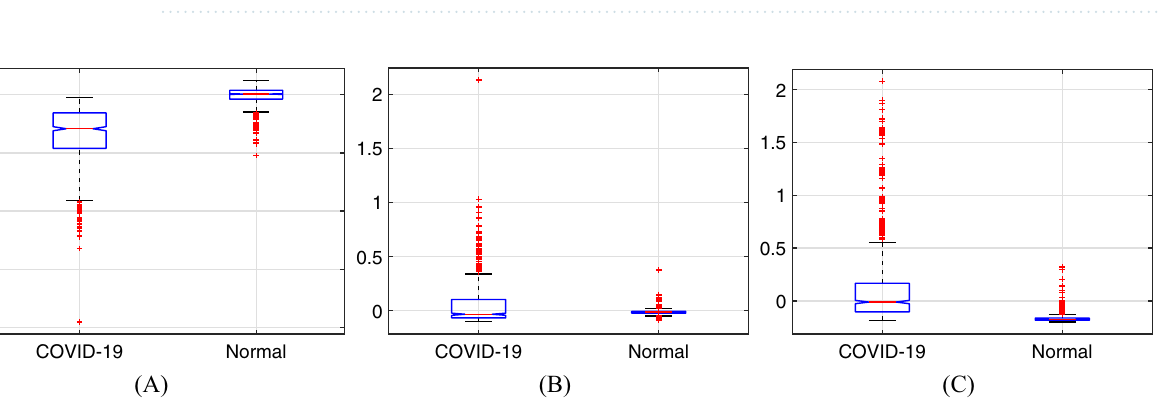
Table 1. Analytic results among training feature samples in the previous three dimensions by one-way ANOVA.